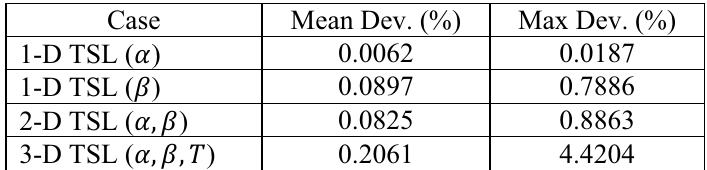
Table I. Percent deviation between test grid labels and predictions